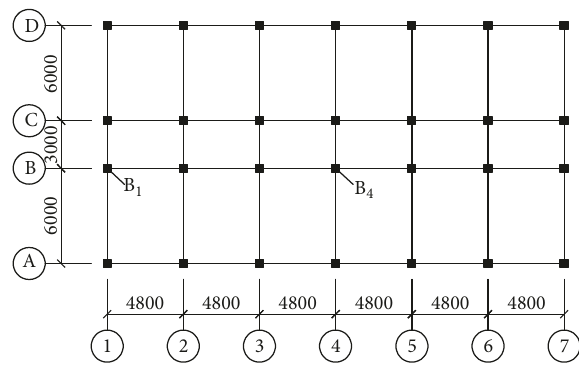
Figure 7: The planar arrangement of the hybrid frame structure.